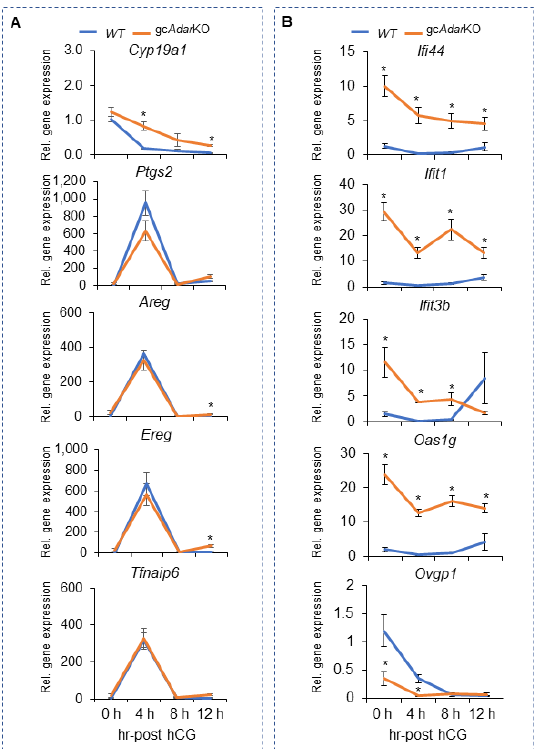
Figure 5. Temporal expression of known LH regulated genes and of selected genes that exhibited difference following granulosa cell deletion of Adar . Quantitative RT-PCR analysis of ( A ) well- known LH regulated genes ( Cyp19a1, Ptgs2, Areg, Ereg, and Tfnaip6) and ( B ) select gc Adar KO differentially expressed genes ( Ifi44, Ifit1 , Ifit3b , Oas1g and Ovgp1) in mural GCs from mice (21 days old) collected 46 h after eCG (0 h) or after eCG followed by hCG for 4, 8, 12 h are depicted and shown. qRT-PCR data represent the mean ± SEM n ≥ 6. * Denotes a significant difference ( p < 0.05) between